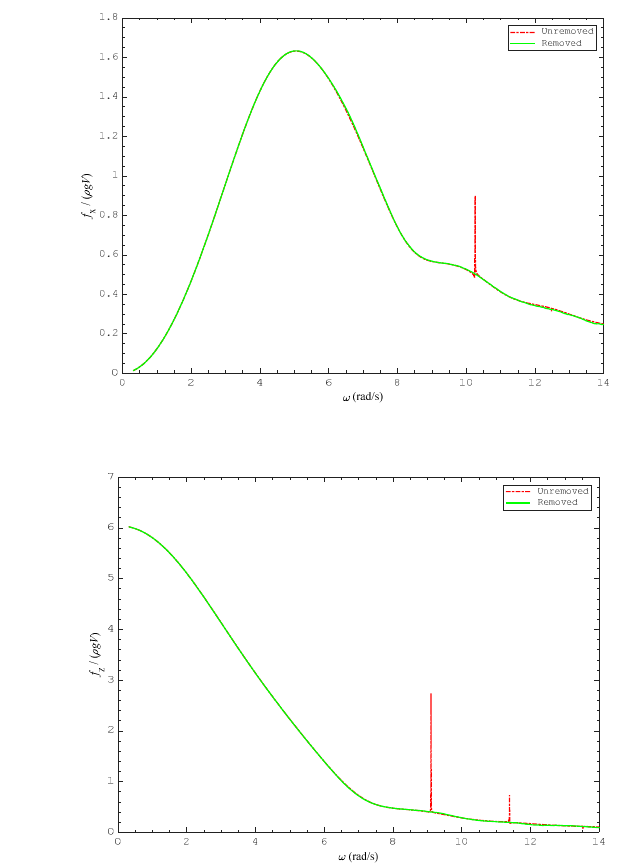
Figure 7. Modulus of the complex exciting wave forces of a floating ellipsoid, as a function of the normalized length 𝑣𝐿 . ( a ) Horizontal exciting force. ( b ) Vertical exciting force.